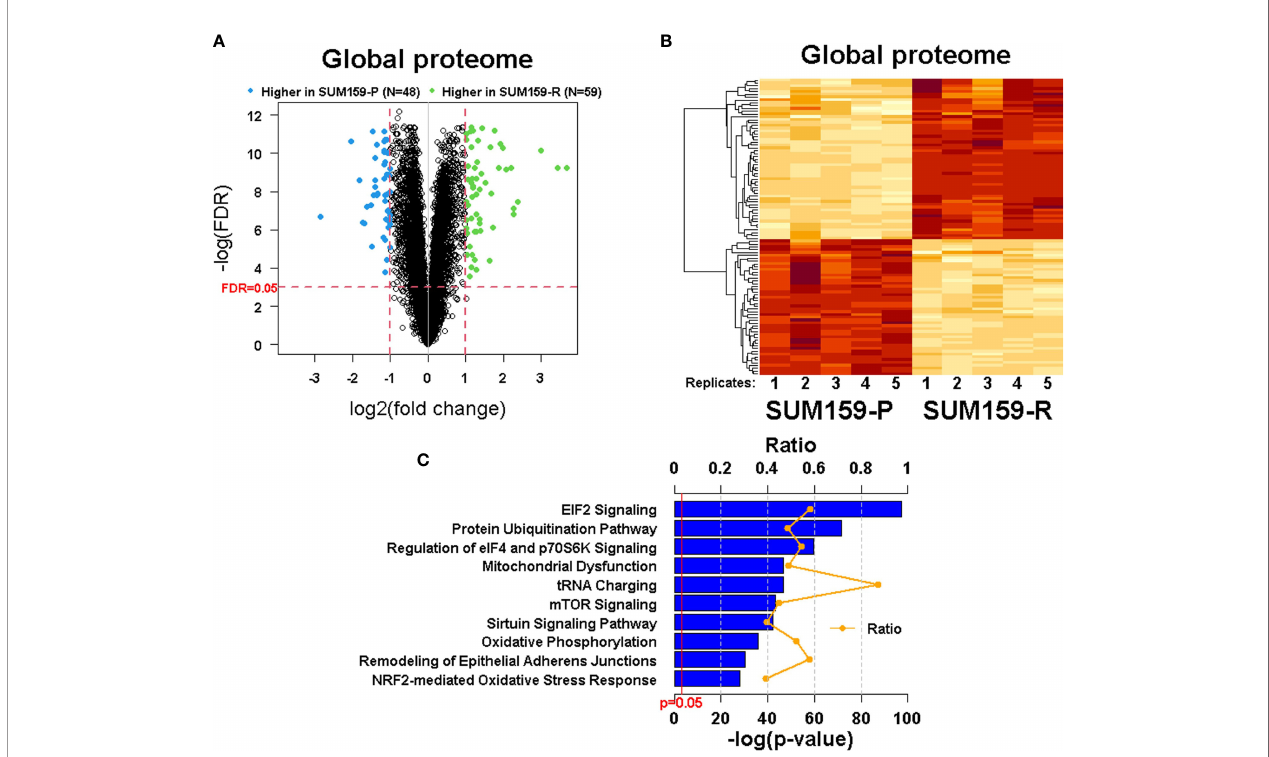
FIGURE 4 | Quantitative measurement of the global proteome using TMT labeling in SUM159 parental and resistant TNBC cells. (A) Volcano plots showing differentially expressed proteins in SUM159-R cells compared to SUM159-P cells. Each dot represents one protein. Blue and green dots represent proteins that are signi fi cantly higher in SUM159-P cells (N = 48) and those that are signi fi cantly higher in SUM159-R cells (N = 59), respectively, with FDR<0.05 and fold change (FC) ≥ 2. (B) Heatmap generated from proteins detected in all samples by hierarchical clustering. FDR<0.05 and FC ≥ 2. (C) Top 10 canonical pathways related to olaparib resistance derived from the global proteome ’ s ingenuity pathway analysis (IPA). P, parental and R,